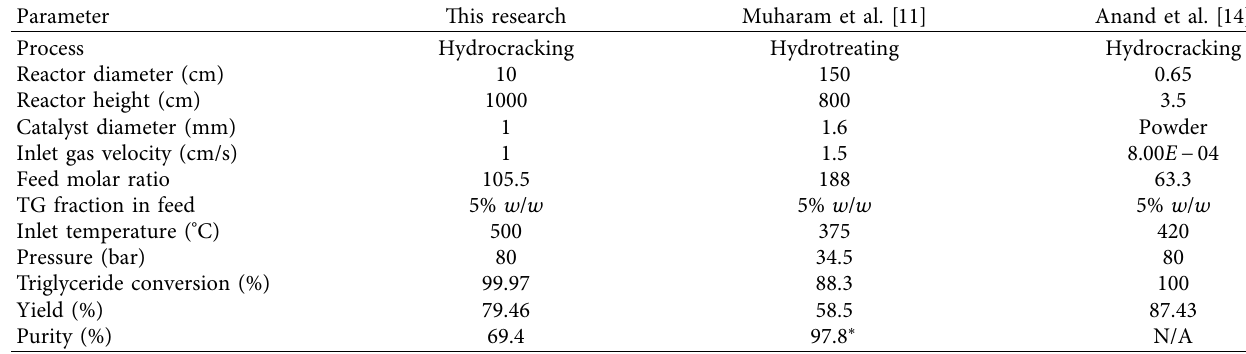
Table 8: Comparison of this study’s results with Muharam et al. [11] and Anand et al. [14].